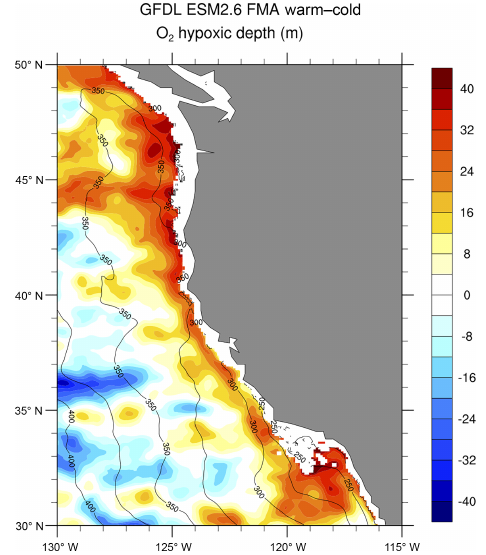
Figure 9. ESM2.6 FMA warm–cold high-pass-filtered anomalies (m) for depth of the hypoxic threshold (O 2 ≤ 60µmolkg − 1 ) and FMA mean climatological depth of the hypoxic threshold (25m in- terval contours). White areas near the coast indicate an absence of the hypoxic level in the vertical layer. Positive numbers indicate a deepening of the hypoxic